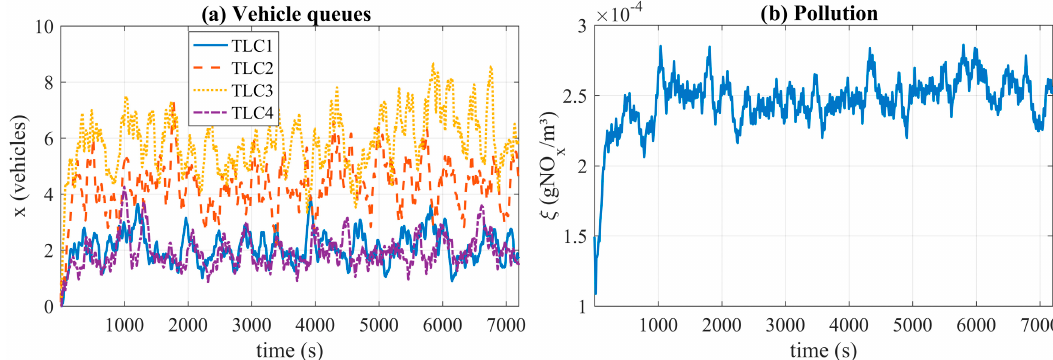
Figure 6 . Vehicle queues ( a ) and pollution behavior ( b ) in an open-loop simulation.